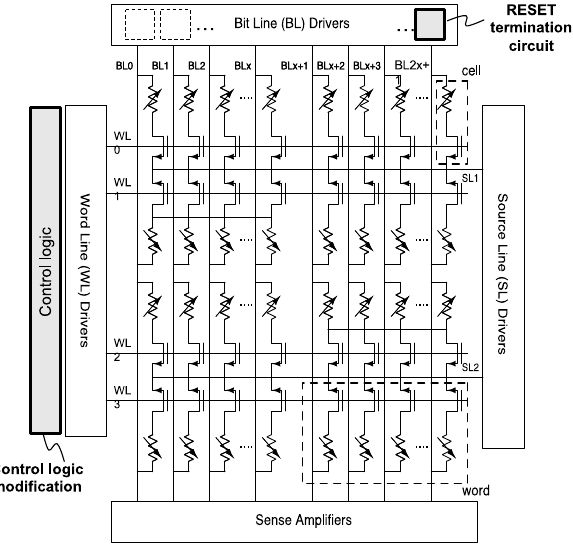
Figure 6. Memory architecture including the modifications required for the implementation of the MLC design scheme.